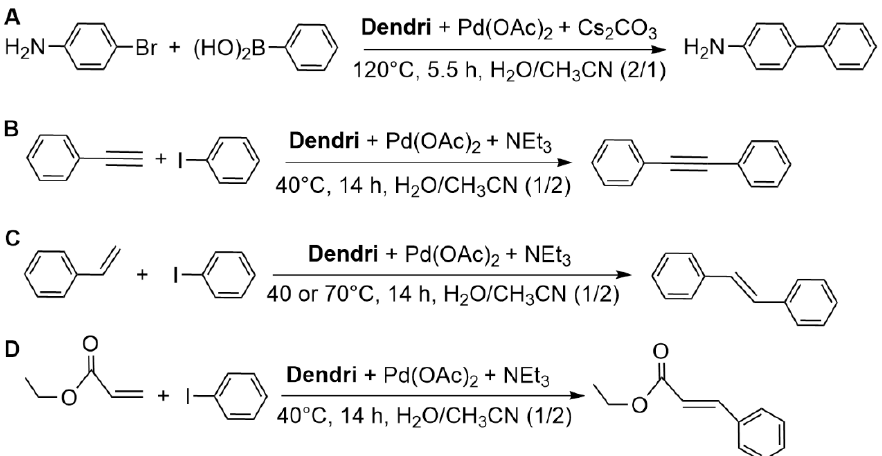
Figure 5. Catalytic reactions carried out with Pd complexes of the dendrimers shown in Scheme 5. ( A ) Suzuki coupling; ( B ) Sonogashira coupling; ( C , D ) Heck couplings.